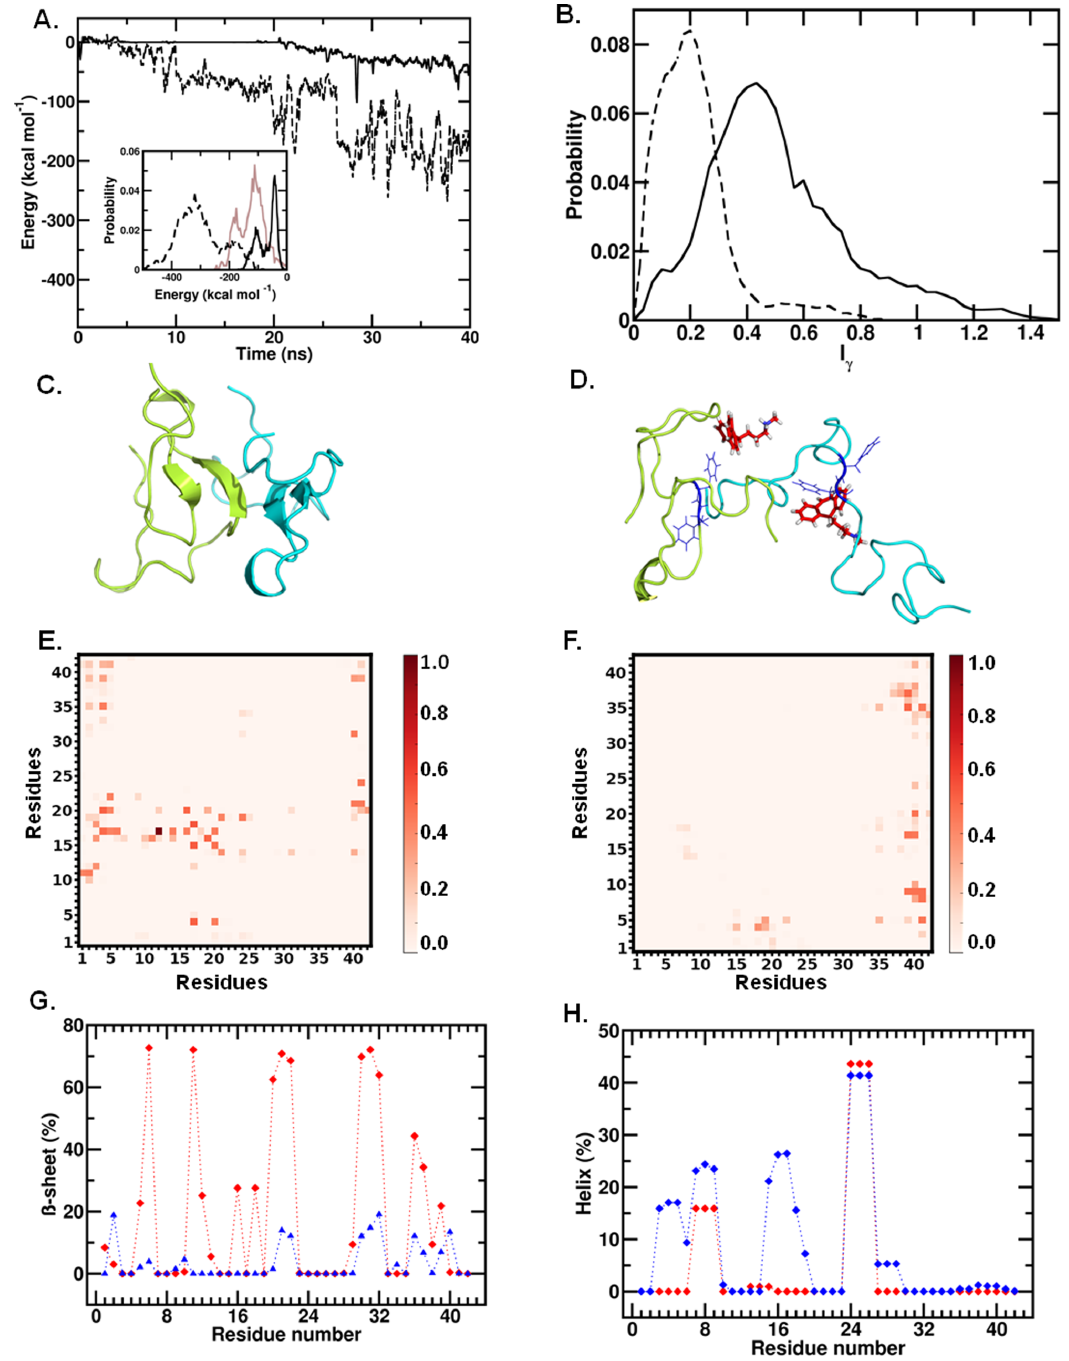
Figure 4. Destabilization of amyloid dimer by protriptyline. A . Evolution of monomer-monomer interaction strength over time for free dimer (broken line) and Protriptylline-bound dimer (solid line). Inset . Distributions of the interactions from multiple trajectories, and the dimer interactions with Protriptylline (in brown) B . Distributions of the asphericity for free (in broken line) and Protriptylline-bound (solid line) dimer C . Representative snapshot of most populated cluster of free, and D . Protriptylline-bound dimer [16–20 region in blue colour with 19–20 showed in line representation; protriptyline in red colour and two A b peptides are in cyan and limon colour respectively] E . Residue-residue contact probabilities for free dimer, and F . Protriptylline-bound dimer G . Residue-wise Beta sheet percentages for free dimer (in red) and Protriptylline-bound dimer (in blue) H . Residue-wise helical percentages for free dimer (in red) and Pro-bound dimer (in blue).